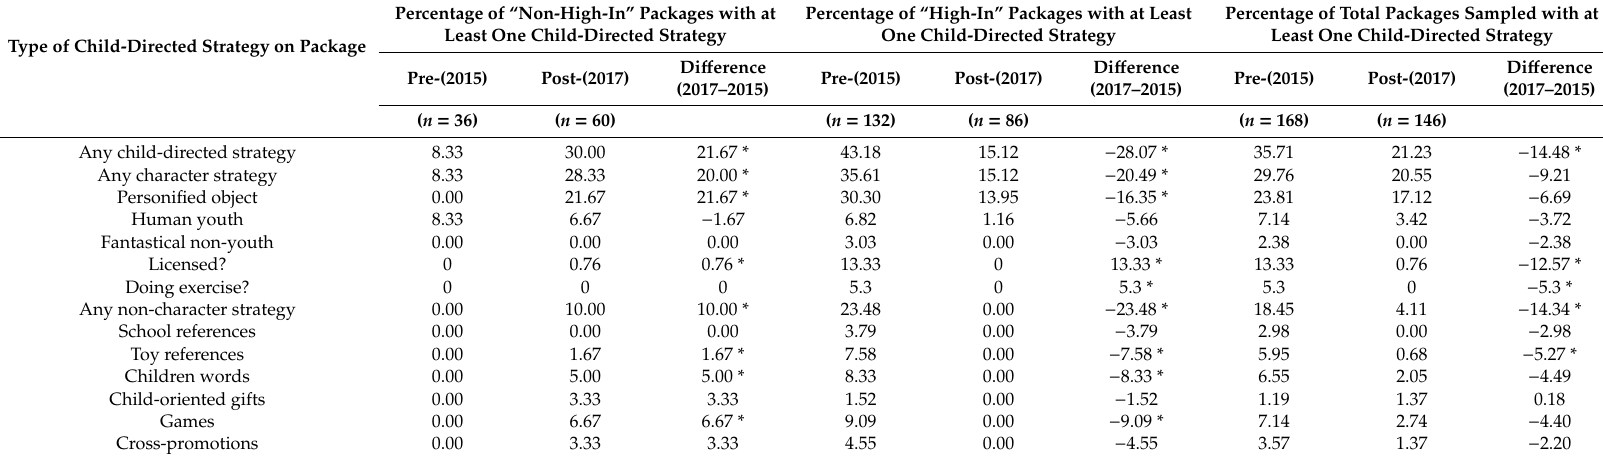
Table3. Di ff erencesinthepercentageofpackagesusingchild-directedstrategieswithin“high-in”and“non-high-in”breakfastcerealsatpre-versuspost-implementation.